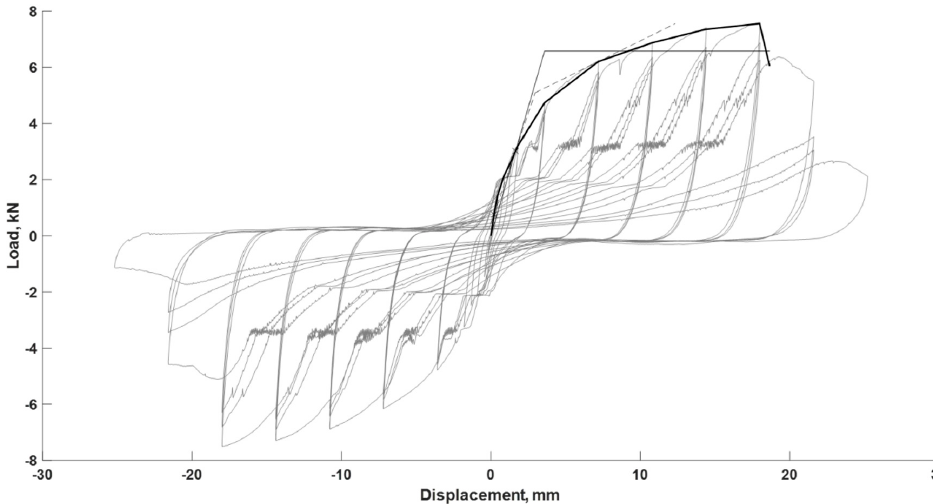
Figure 6. Load–displacement plot of specimen WSP6 including backbone curve.